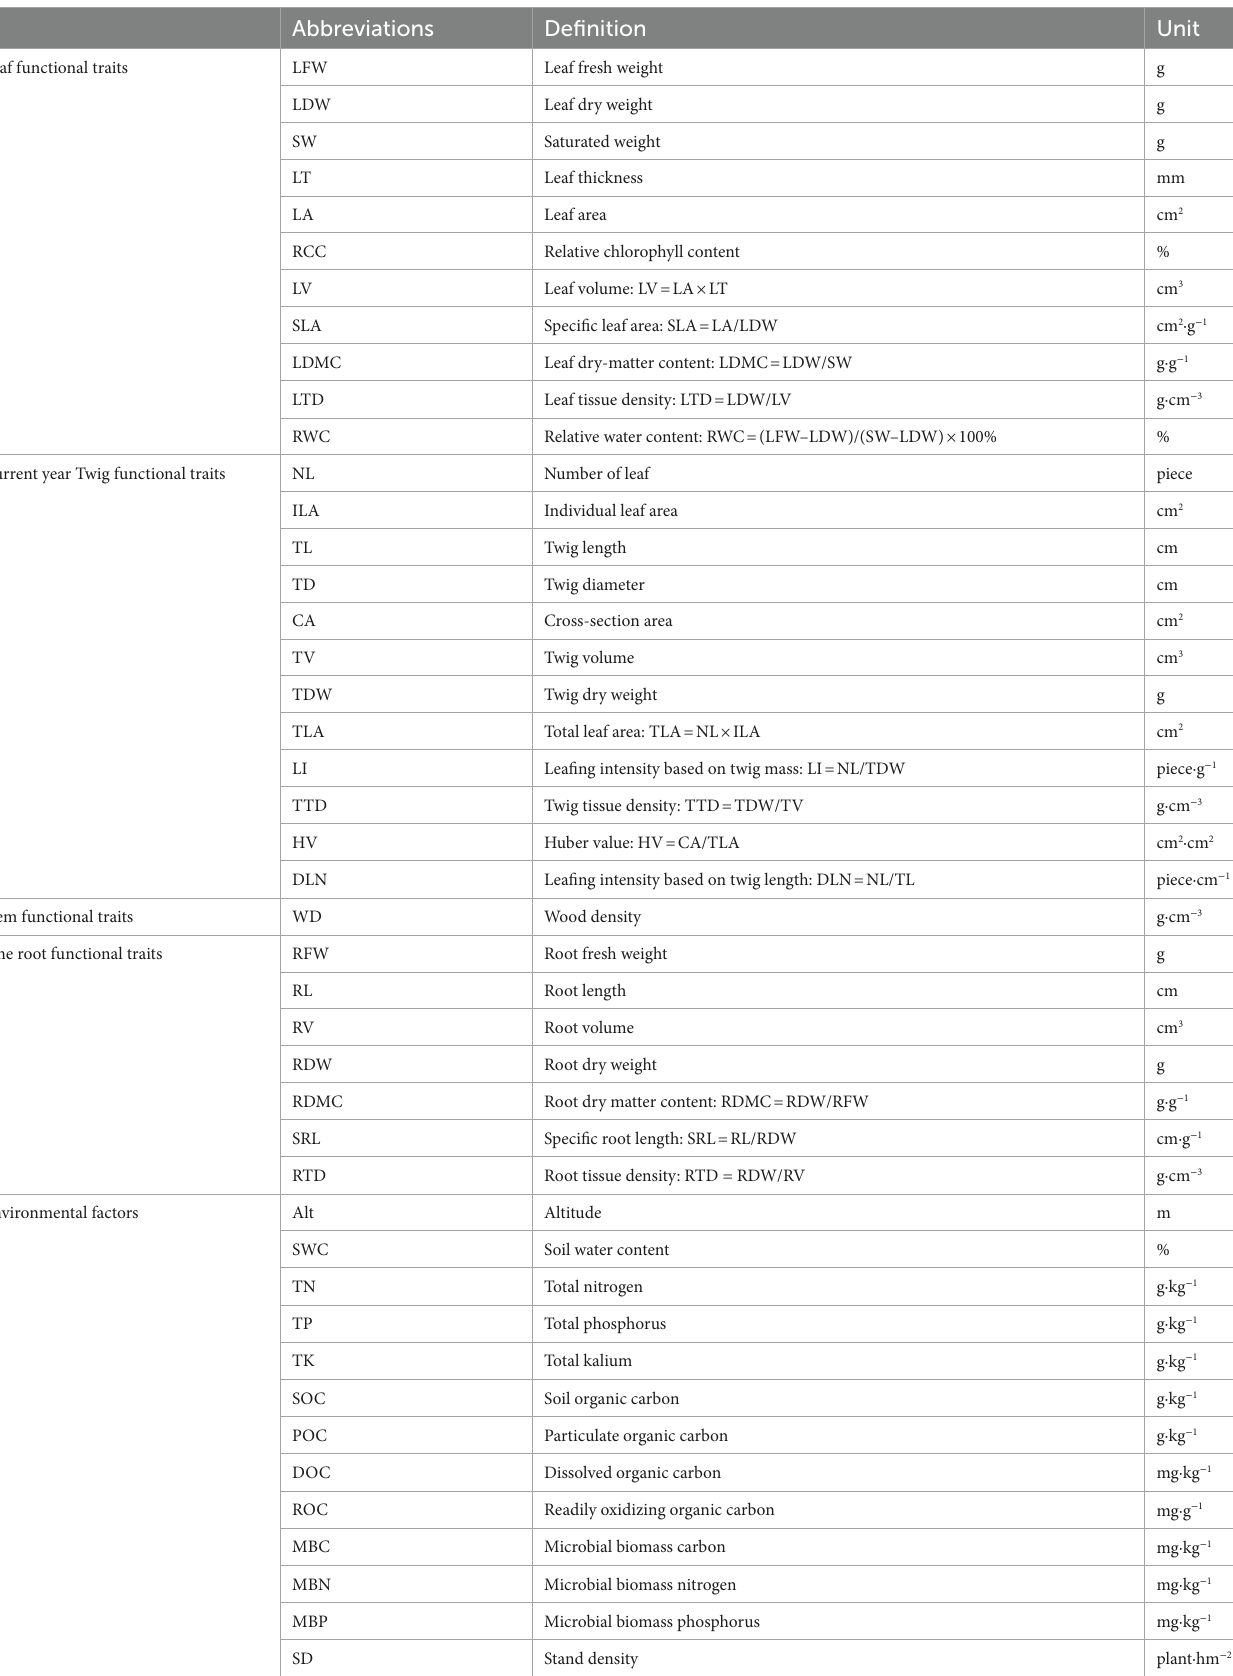
TABLE 2 The abbreviations of functional